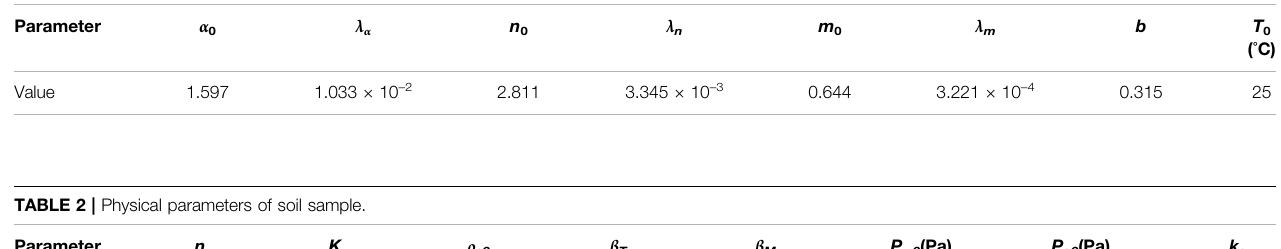
TABLE 1 | Modi fi ed VG model parameters.